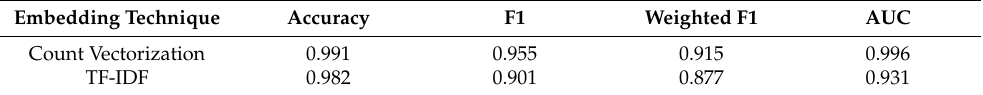
Table A2. Performance metrics for the Multinomial naïve Bayes.